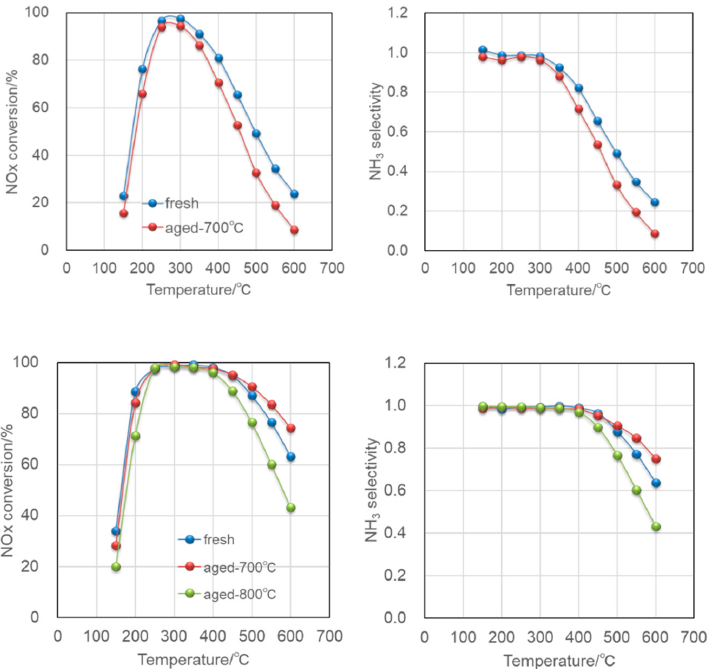
Figure 1. Catalytic performances of SSZ-13 ( top ) and AFX ( bottom ) for NH 3 -SCR. ( Left ) NO con- versions on fresh and hydrothermally-aged catalysts; ( right ) NH 3 selectivity for SCR.